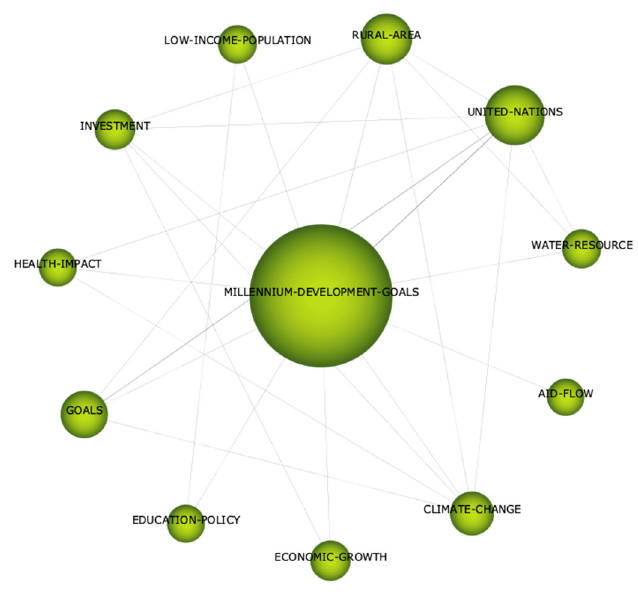
Figure 5. Thematic network for period 2.